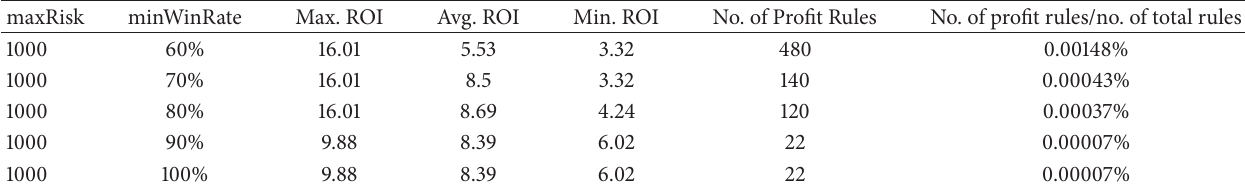
Table 9: Mining results of using various minWinRates with maxRisk = 1000.